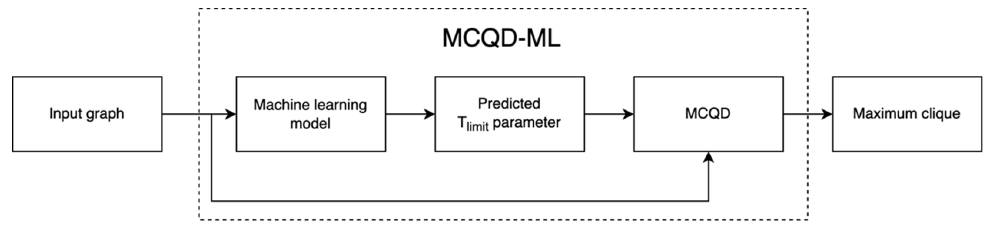
Figure 1. MCQD-ML algorithm